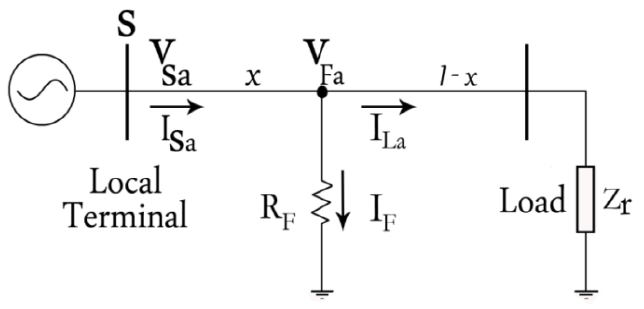
Figure 1. Single-line diagram of the faulty distribution system. V Sa : voltage of phase a . x [km]: distance from the beginning of the section to fault location in km. Z L impedance per 1 km of the faulty line).